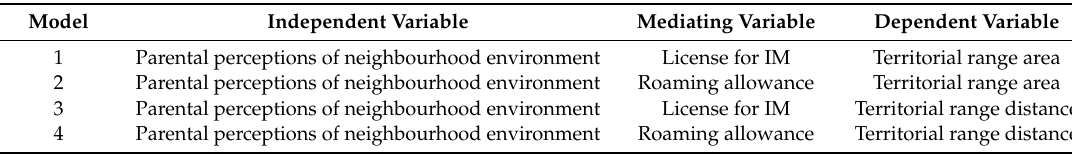
Table 1. Conceptual models for path analyses.